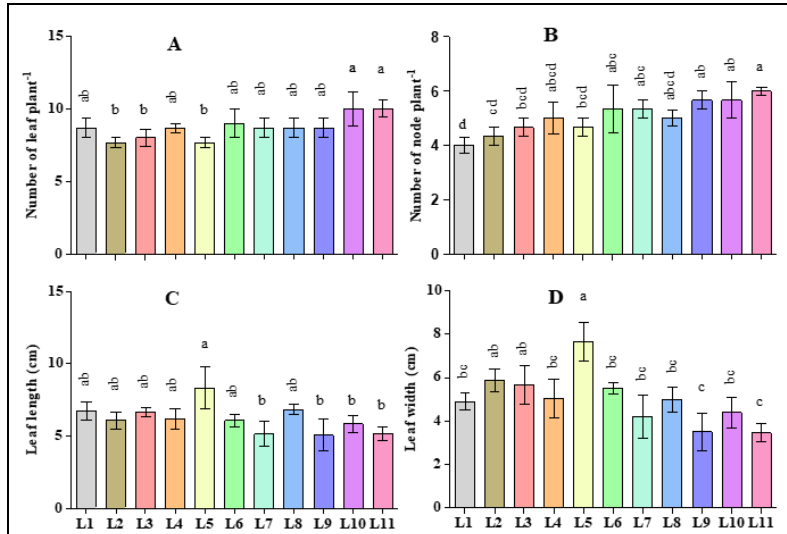
Figure 3. Effect of 20 days exposure to different LED spectra on the number of leaves plant −1 ( A ), number of nodes plant −1 ( B ), leaf length ( C ), and leaf width ( D ) of hemp seedlings. Here and subsequent figures: L1, Natural light; L2, White; L3, R 8 :B 2 ; L4, R 7 :B 2 :G 1 ; L5, R 7 :B 2 :FR 1 ; L6, R 6 :B 2 :G 1 :FR 1 ; L7, R 5 :B 2 :W 2 :FR 1 ; L8, R 5 :B 2 :G 1 :FR 1 :UV 1 ; L9, R 6 :B 2 :FR 1 :UV 1 ; L10, R 4 :B 2 :W 2 :FR 1 :UV 1 ; L11, R 2 :B 2 :G 2 :W 2 :FR 1 :UV 1 . All treatments used a photosynthetic photon flux density of 300 µ mol m − 2 s − 1 . Column height indicates the mean, vertical bars indicate the standard error of the mean (n = 4), and different letters indicate significant differences at p <